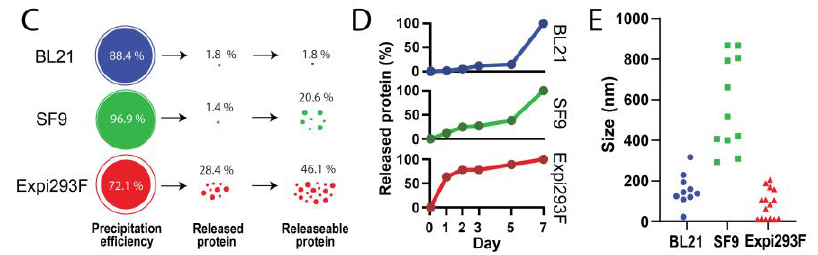
Figure 4. Comparative characterization of the protein materials. ( A ) TEM images of the purified protein samples used for the construction of nanoparticles. Only the bacterial products formed oligomers. Scale bar size: 50 nm. ( B ) FESEM images of the microparticles formed out of the materials shown in A. Scale bar size: 6 µm. ( C ) Precipitation efficiency of the soluble protein into microparticles, in % of the starting material. The fraction of released protein upon 7 days of incubation at 37 °C is indicated, as well as the total fraction of protein released to the soluble fraction from the granules, when forced by Zn chelation mediated by EDTA, at day 7. ( D ) Kinetics of protein release from the microscale granules, referring to the maximal amount of released protein at the end of the experiment. ( E ) Size of the materials released from microparticles in samples taken on days 1 and 3 of the 7-day release experiment.